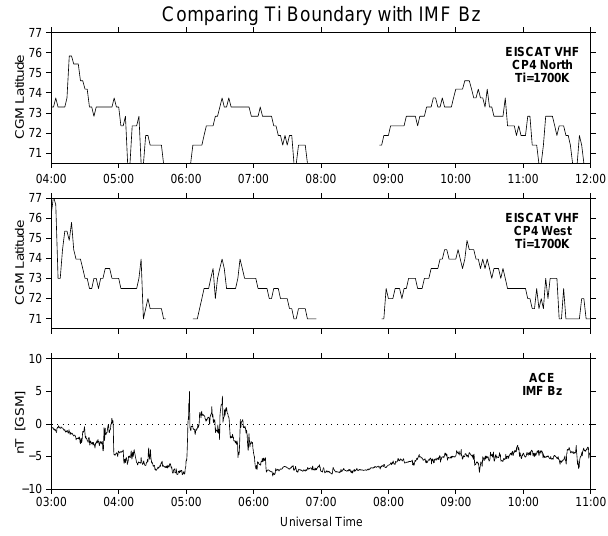
Fig. 8. The upper two panels show the T i =1700K isocontour boundary derived from EISCAT Beam 1 and Beam 2, and the bot- tom panel shows IMF B Z observed by ACE. Note that the ACE time scale is shifted by one hour relative to the EISCAT